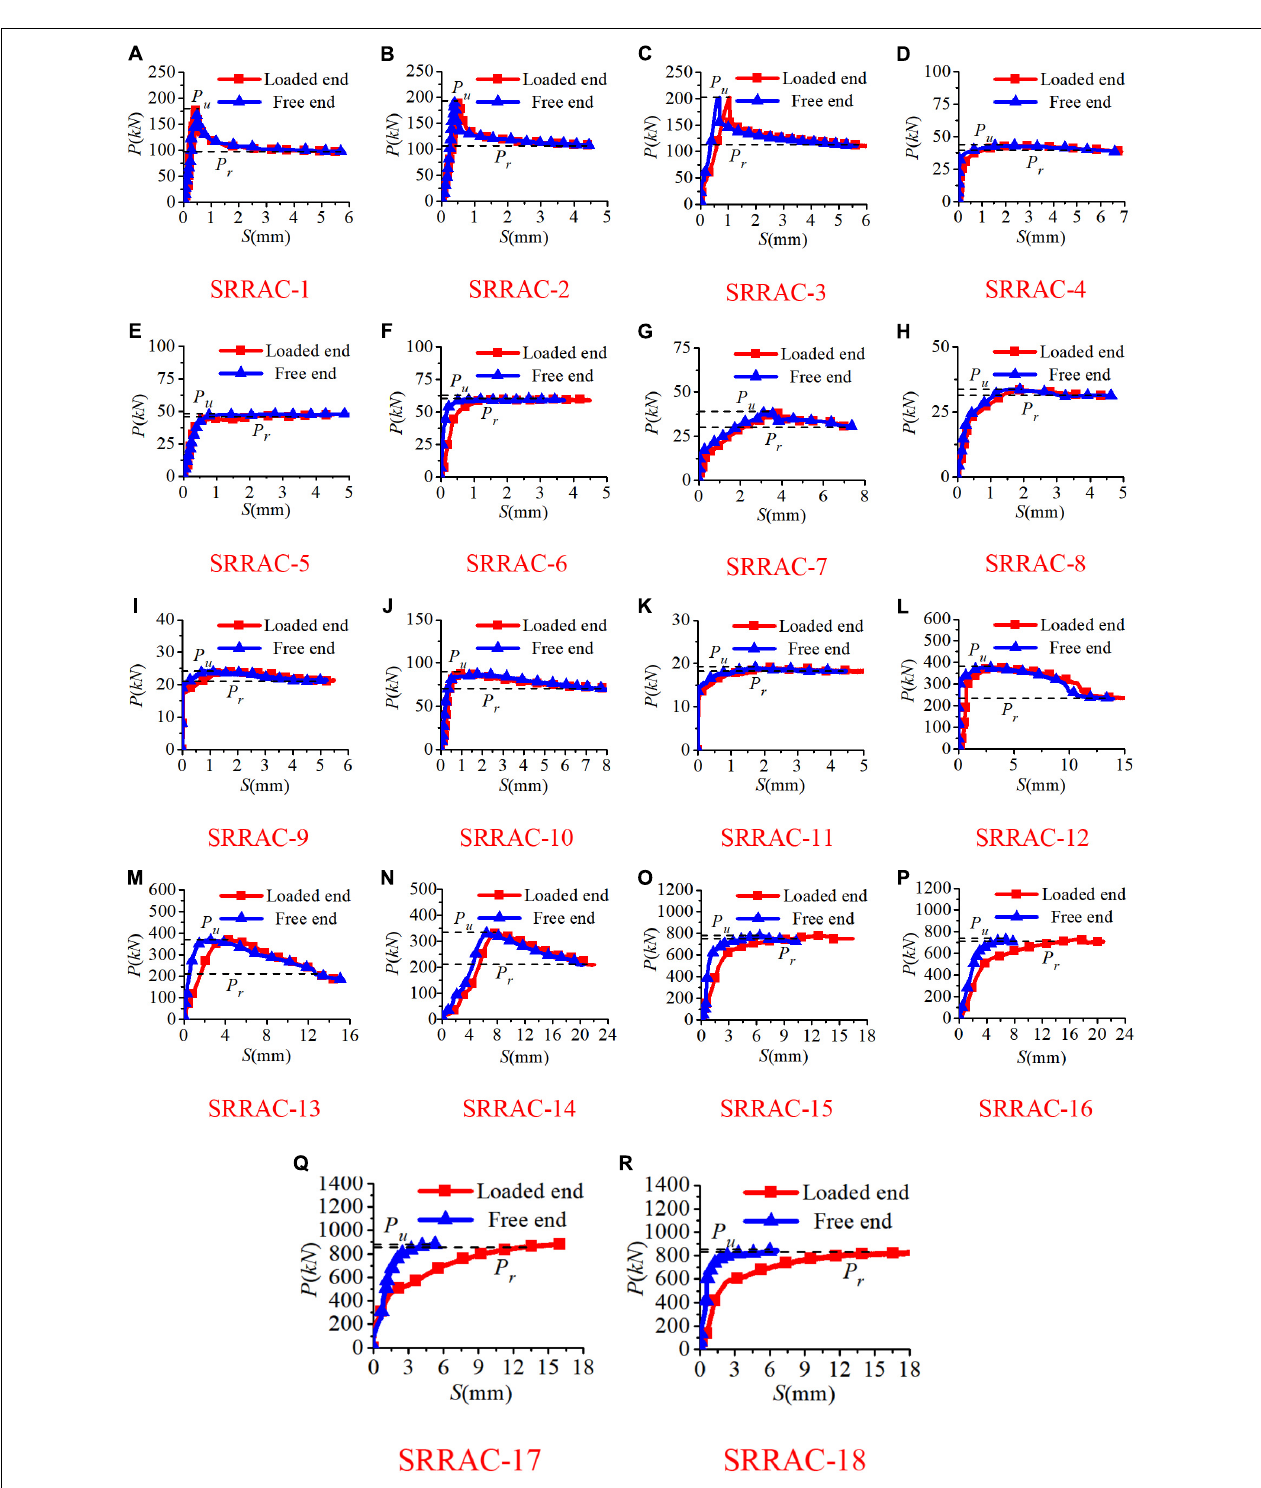
FIGURE 5 | P–S curves of specimens. (A) SRRAC-1. (B) SRRAC-2. (C) SRRAC-3. (D) SRRAC-4. (E) SRRAC-5. (F) SRRAC-6. (G) SRRAC-7. (H) SRRAC-8. (I) SRRAC-9. (J) SRRAC-10. (K) SRRAC-11. (L) SRRAC-12. (M) SRRAC-13. (N) SRRAC-14. (O) SRRAC-15. (P) SRRAC-16. (Q) SRRAC-17. (R) SRRAC-18.